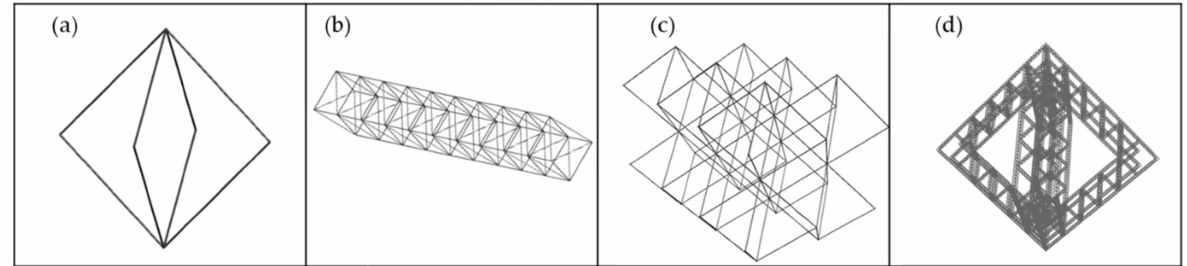
Figure 7. ( a ) Single octahedron design, ( b ) Octahedron microstructure bar made of 9 octahedrons, ( c ) 6 octahedrons microstructure, ( d ) Big octahedron microstructure made of octahedron bars and octahedron